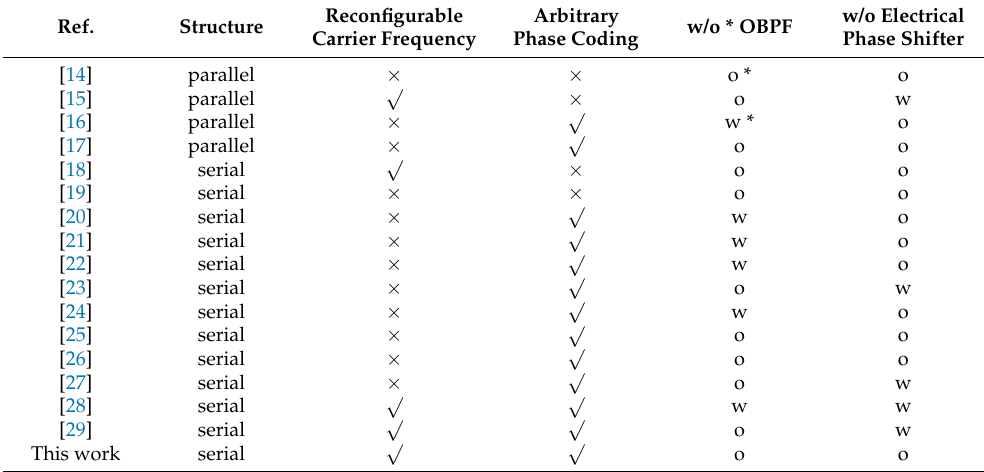
Table 1. Performance comparison of several photonics phase-coded microwave signal generators.